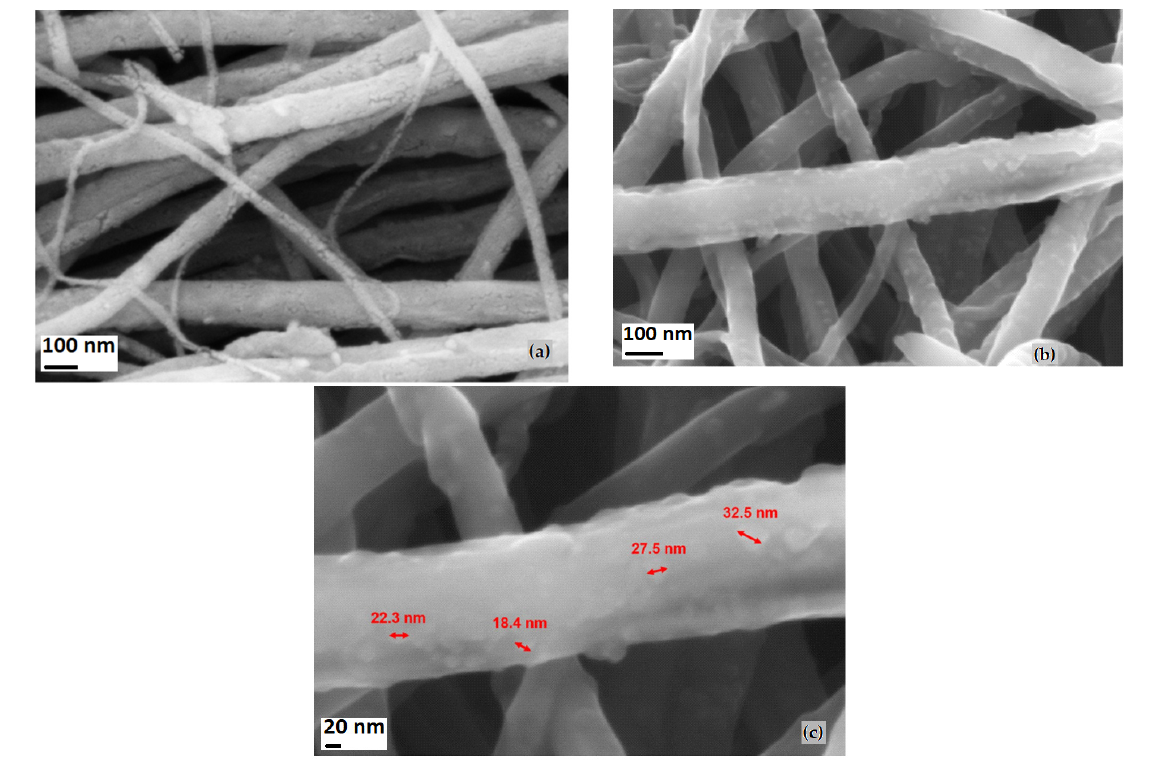
Figure 4. SEM images of f ‐ MWCNTs/Cu nanocomposite obtained by ( a ) physical and ( b ) chemical methods; ( c ) higher magnification of ( b ).